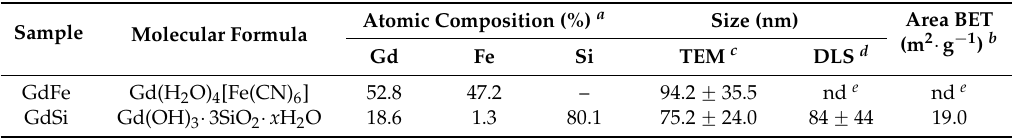
Table 1. Compositional and textural characteristics of as-synthesized materials.